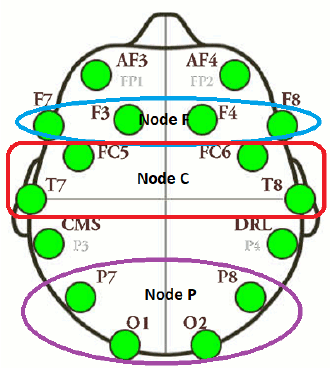
Figure 6. Electrodes layout of F, C and P